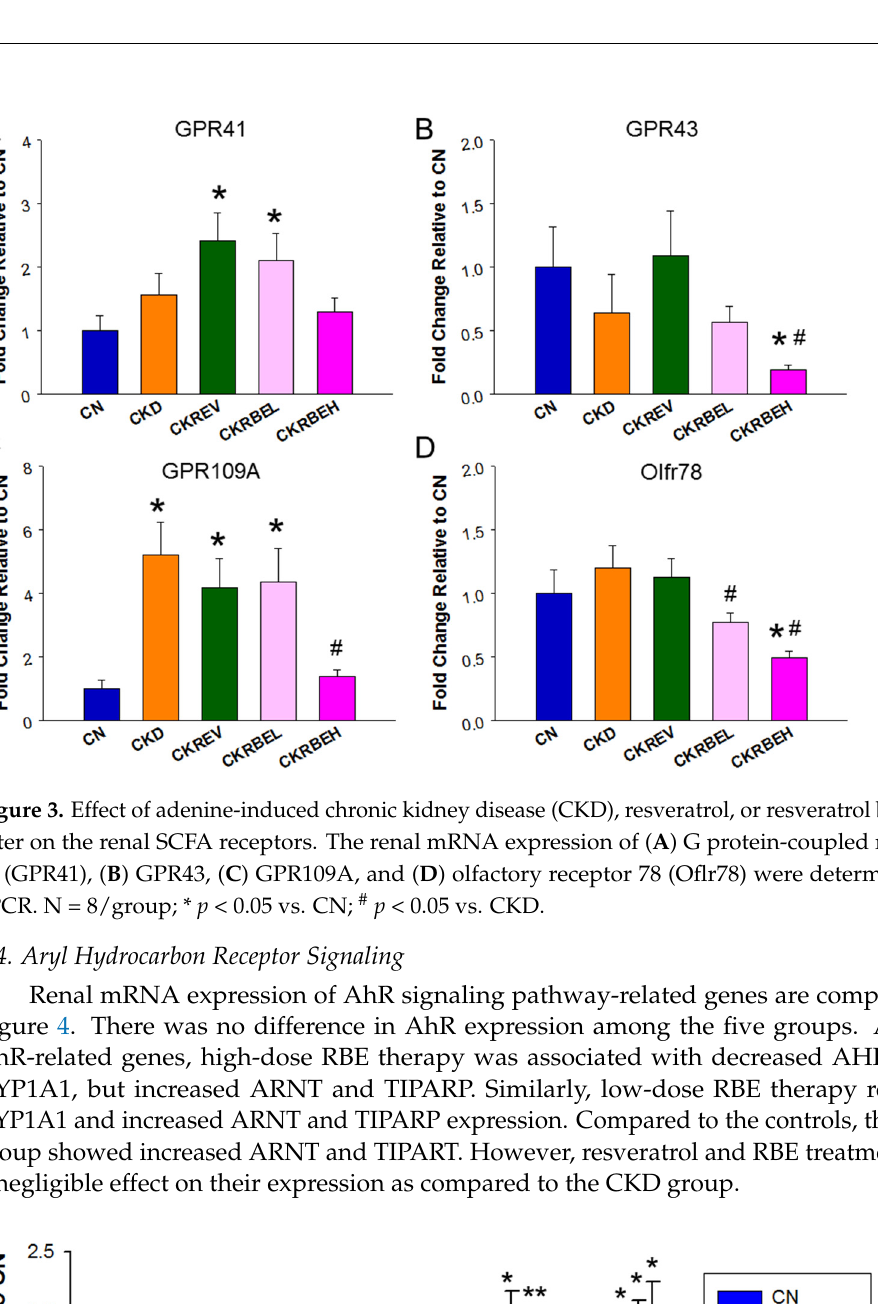
7 of 14 Table 4. Plasma short chain fatty acid levels. Groups